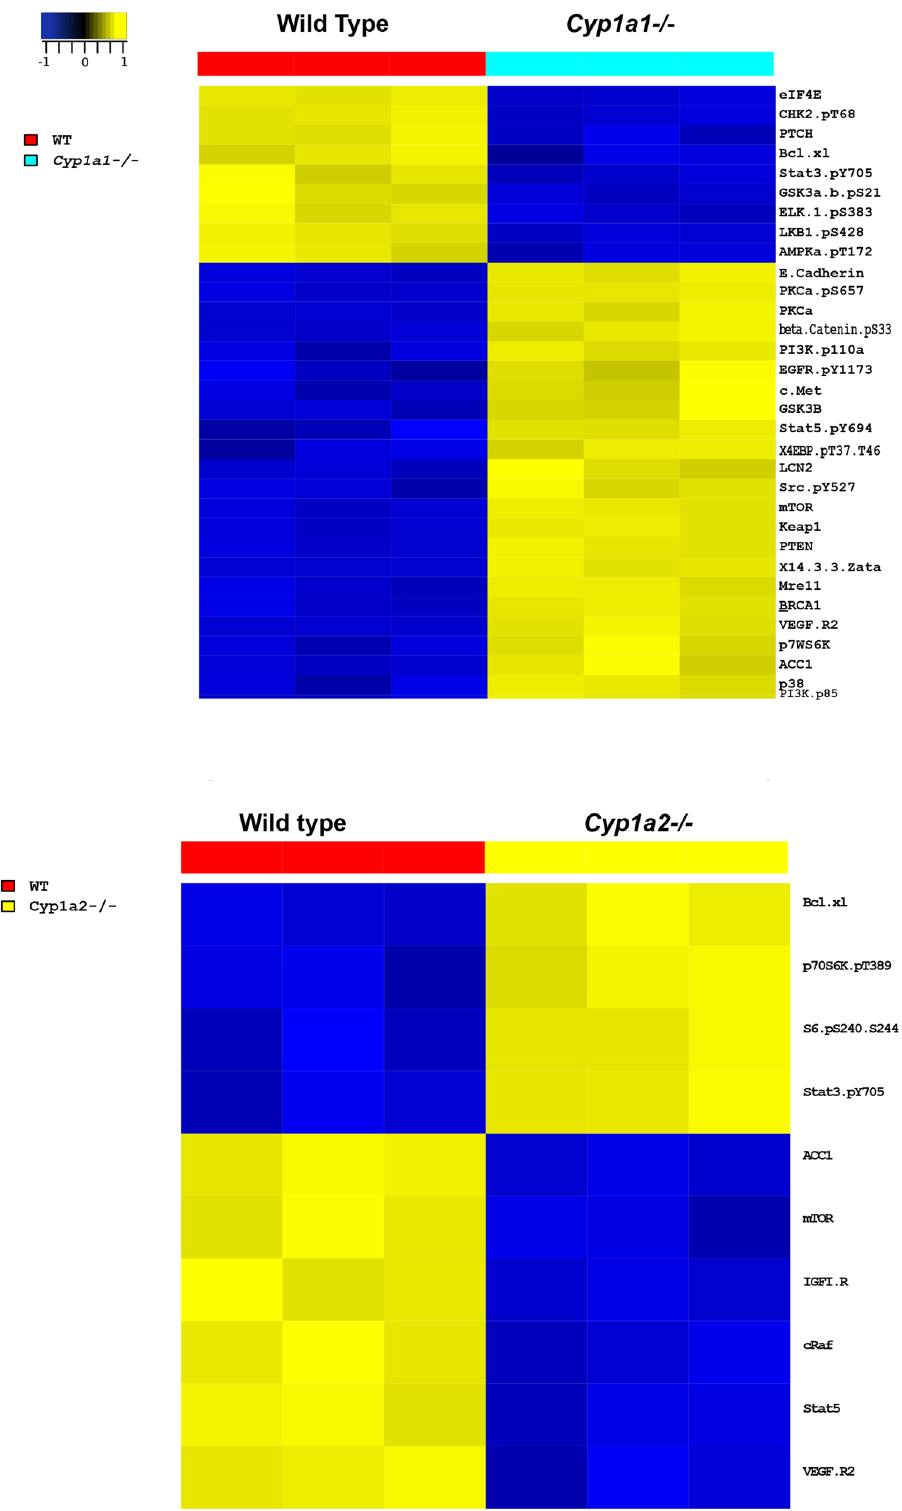
Figure 5. Hyperoxia-exposed Cyp1a1 − / − and Cyp1a2 − / − mice are characterized by robust and distinct proteomic changes compared to hyperoxia-exposed WT. Reverse Phase Protein Analysis (RPPA) was used to generate proteomic profiles of WT, Cyp1a1 − / − and Cyp1a2 − / − mice exposed to hyperoxia. Differential protein expression was evaluated using parametric t-test (significance for fdr-adjusted q-value < 0.25). For a uniform visual representation, expression of each protein were z-score transformed; e.g. for each protein, values were first mean-centered across all samples, then further divided by the standard deviation across all samples. A. Proteomic changes of Cyp1a1 − / − mice compared to WT mice exposed to hyperoxia B. Proteomic changes of Cyp1a2 − / − mice compared to WT mice exposed to